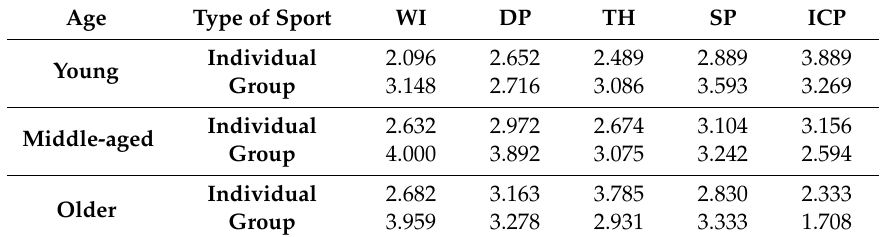
Table 7. Mean scores for interaction effects.